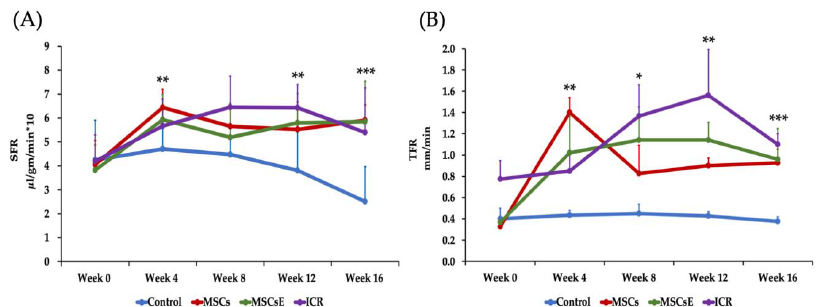
Figure 1. Salivary and lacrimal glands function represented as SFR (Salivary Flow Rate) and TFR (Tear Flow Rate), respectively. SFR and TFR were assessed pre-treatment at week 0 (8-week-old) then 4, 8,